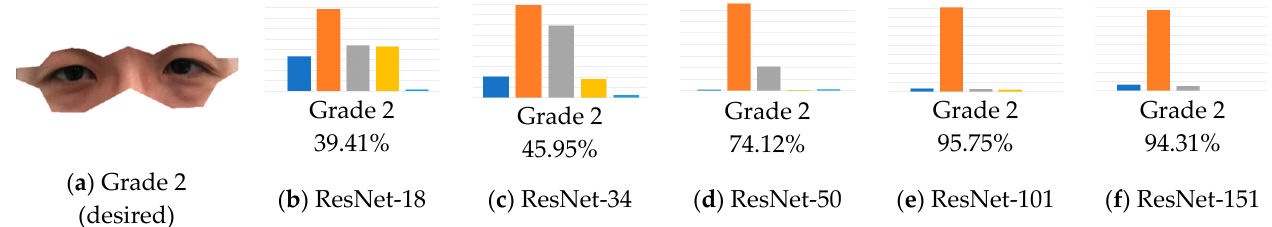
Figure 9. Example and training results of Grade 2 eye wrinkles.